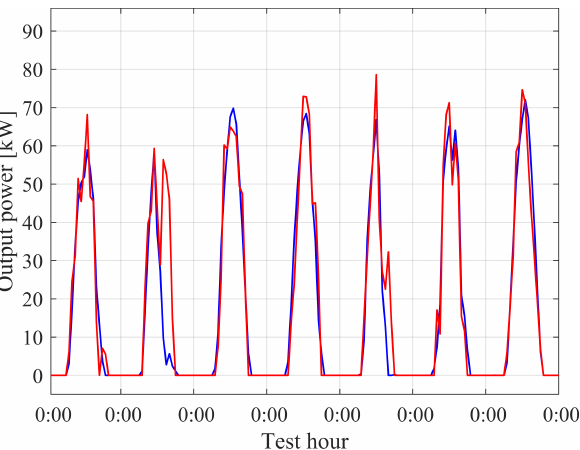
Figure 7. Predicted (red) and real (blue) value of output power in the mid of June 2018 by using the 2D-CNN approach with { S 1 , S 2 } as the best combination on 7-day test set (see Table 5, row 2, column